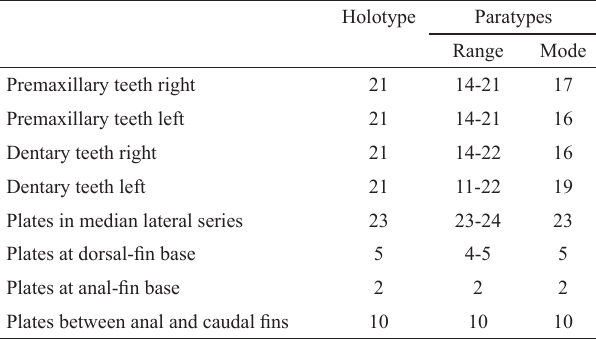
Table 2. Meristic data of holotype (MZUSP 113422) and 24 paratypes of Parotocinclus seridoensis .